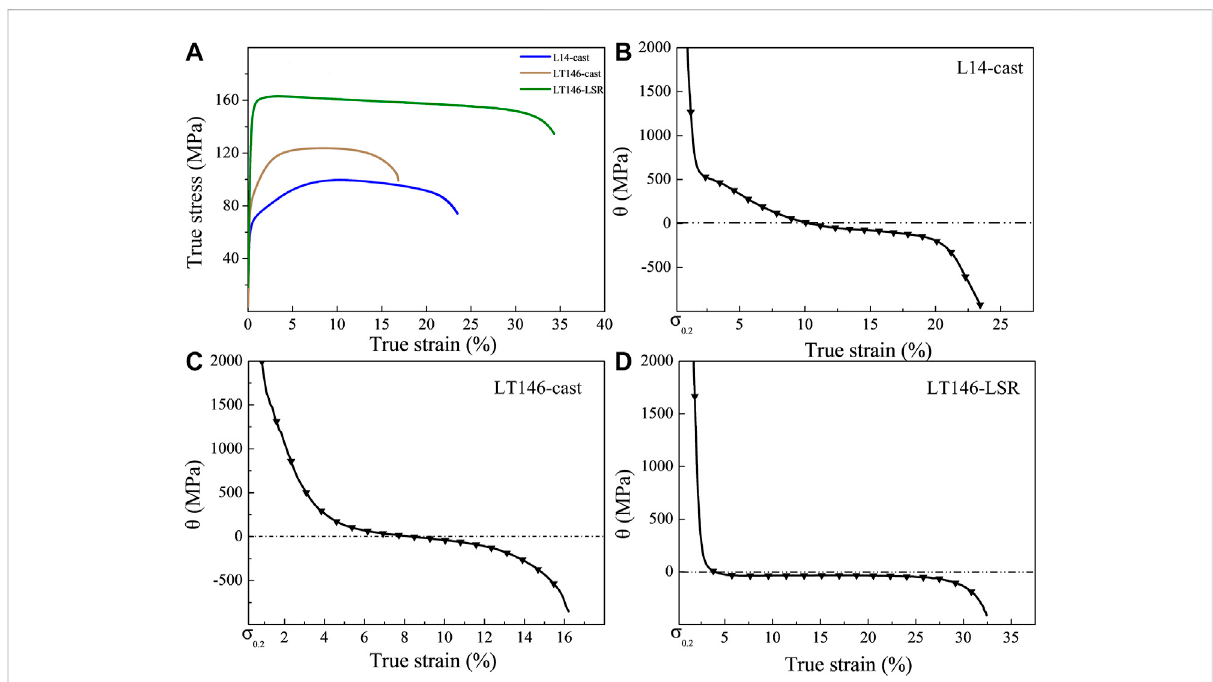
FIGURE 5 Mechanical properties. (A) True stress — true strain curve for as-cast L14, as-cast LT146 and LT146-LSR, (B) work hardening rate-true strain curvesoftheascastL14, (C) workhardeningrate-truestraincurvesoftheascastLT146, (D) workhardeningrate-truestraincurvesoftheLT146-LSR.